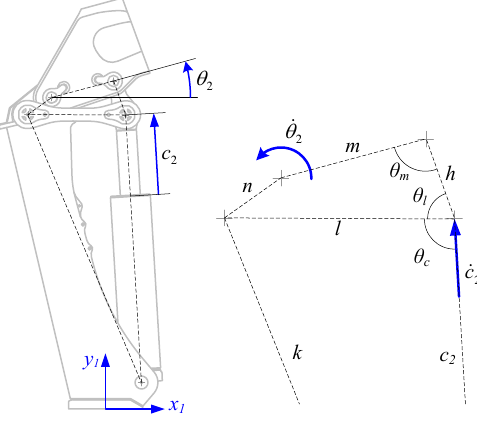
Figure 10: Cylinder coupling through linkage system.